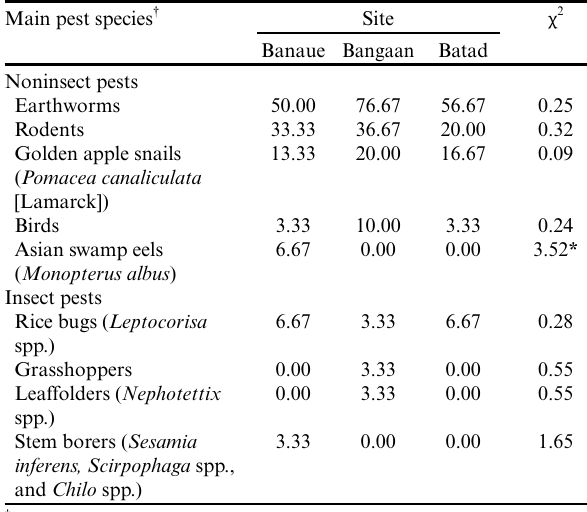
Table 4 . Percentage of households that considered species as the main pest species in their field in each surveyed Barangay of the Banaue